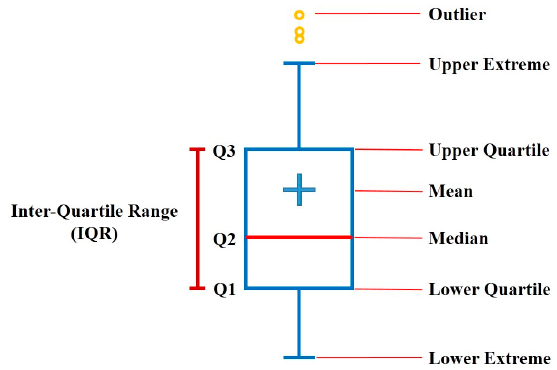
Figure 7. The structure diagram of the boxplot.